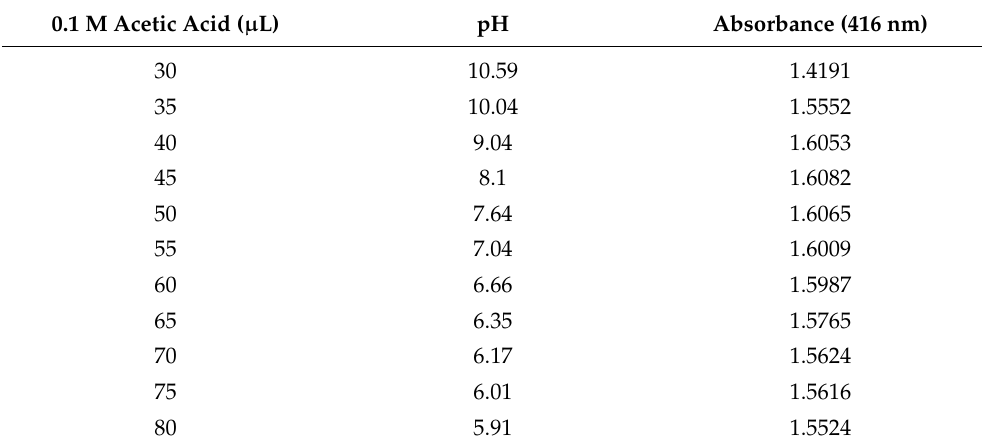
Table 1. Change in pH and Absorbance of indicator solution in response to acetic acid.